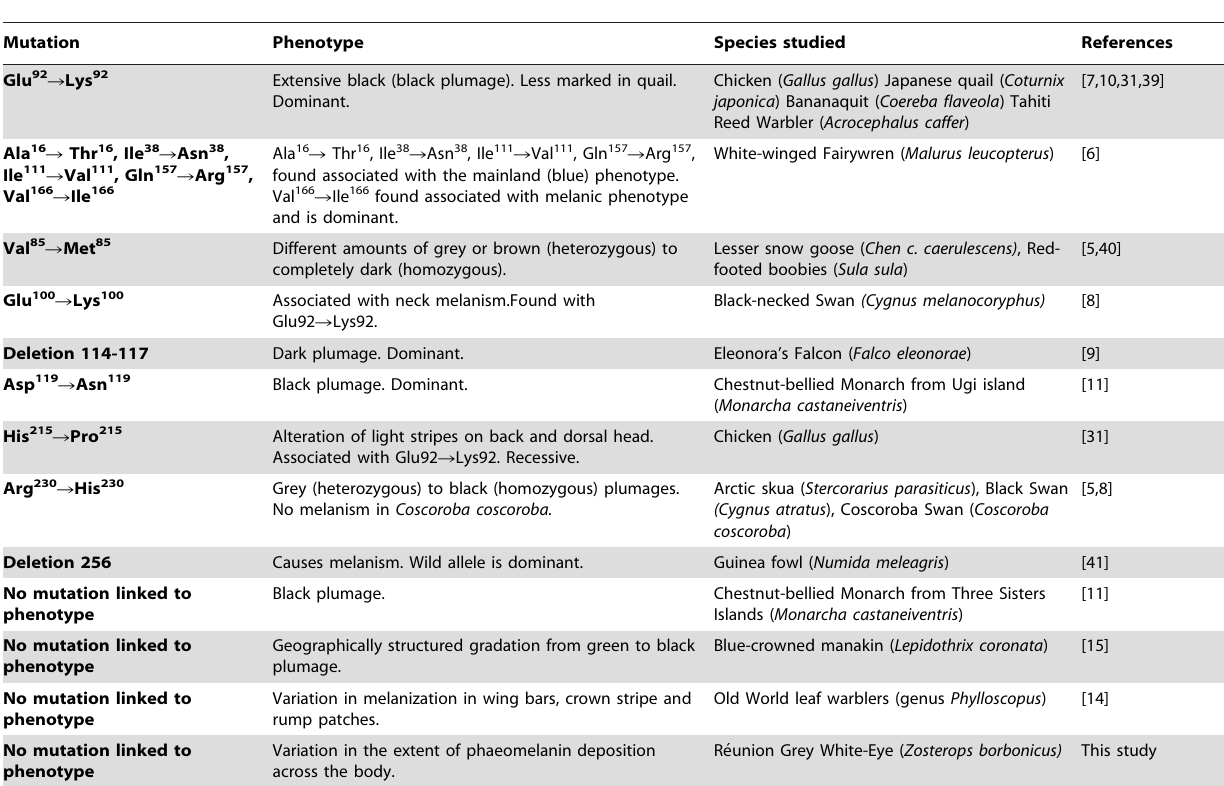
Table 1. Summary of major patterns of melanic variation in birds and their link with MC1R